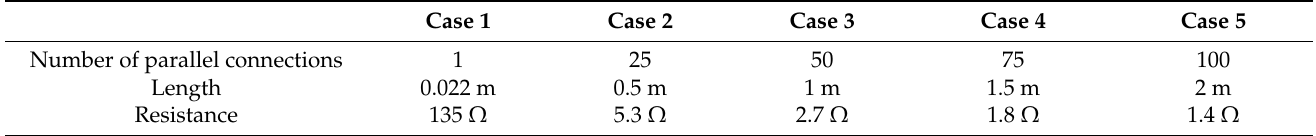
Table 1. Experimental conditions of electrothermal